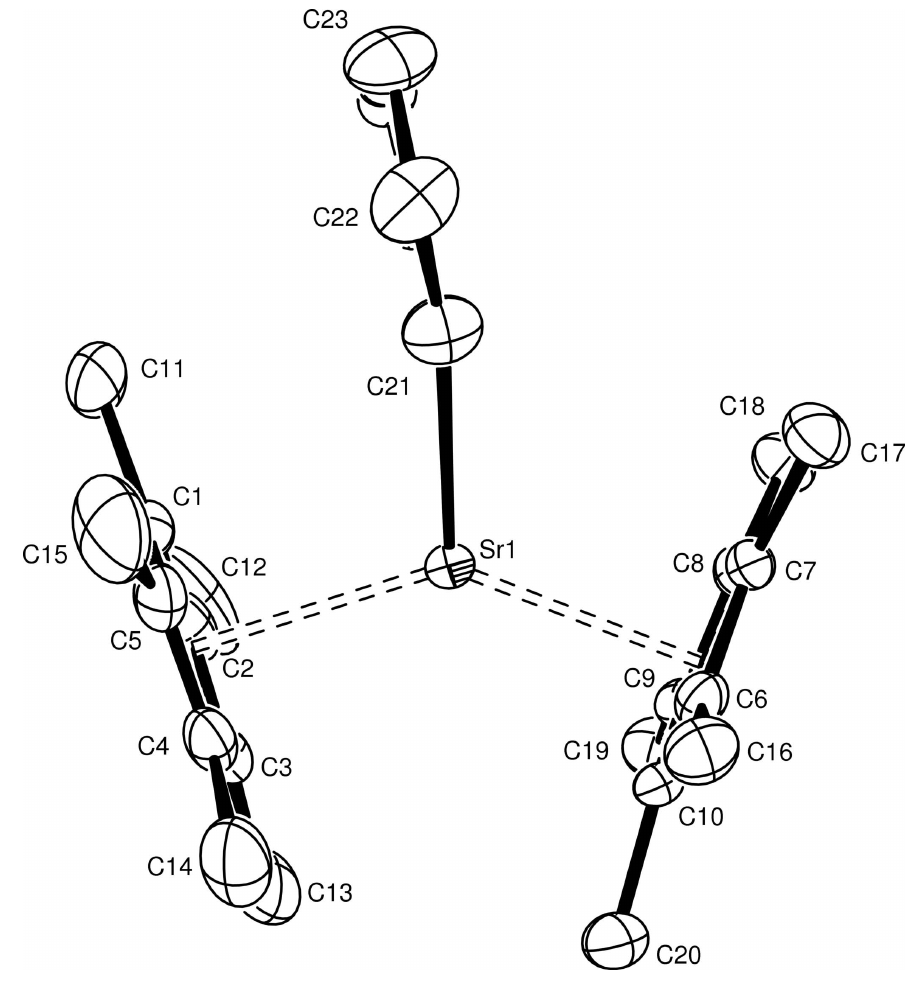
Figure 2 Side view of the structure of ( η 5 -C Hydrogen atoms have been omitted for